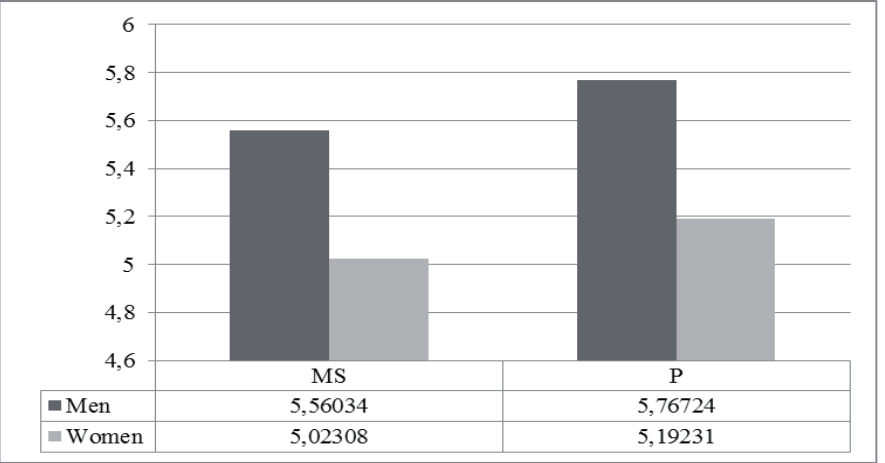
Figure 1. Statistically signi  cant differences of money attitudes of men and women MS- «Money as a means of achieving and demonstrating success», P - «Power»